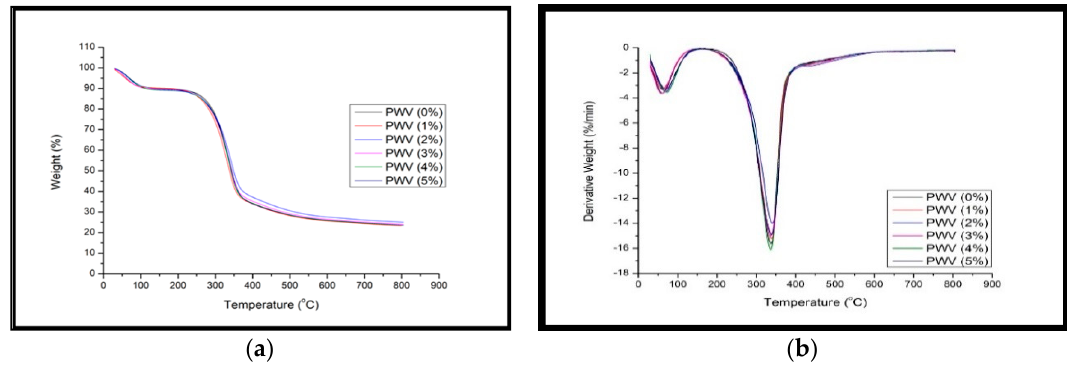
Figure 12. a ) Thermogravimetry (TGA) and b ) Derivative Thermogravimetric (DTG) of PWV with